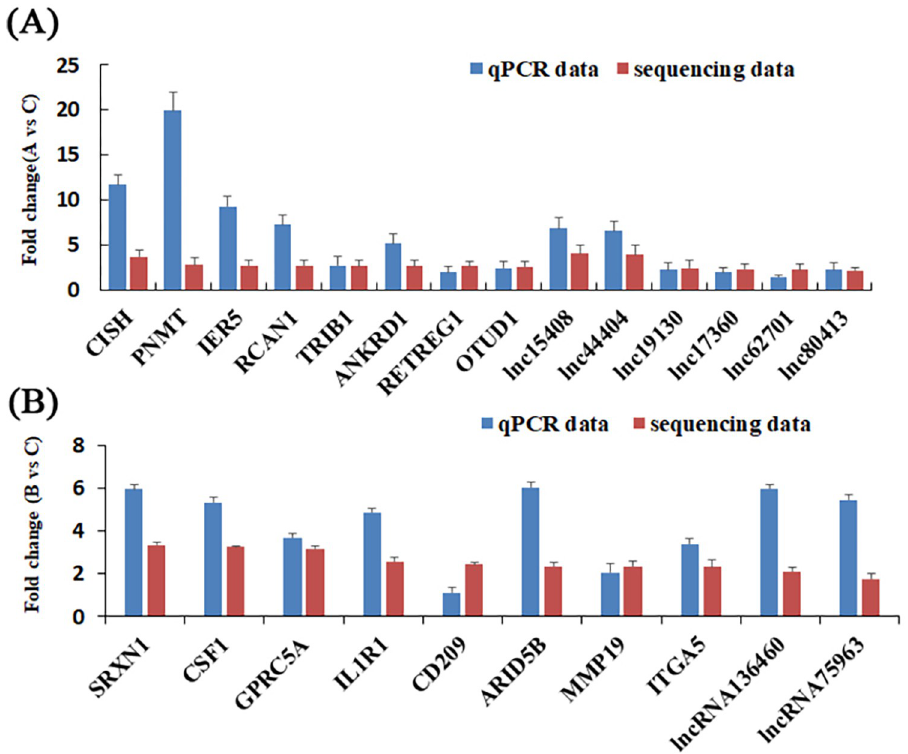
Fig 5. The differential expression of lncRNAs and mRNAs validated by quantitative real-time PCR (qRT-PCR). A. The qRT-PCR and RNA-seq results of chronic low-temperature acclimation group. B. The qRT-PCR and RNA-seq results of acute short cold stress